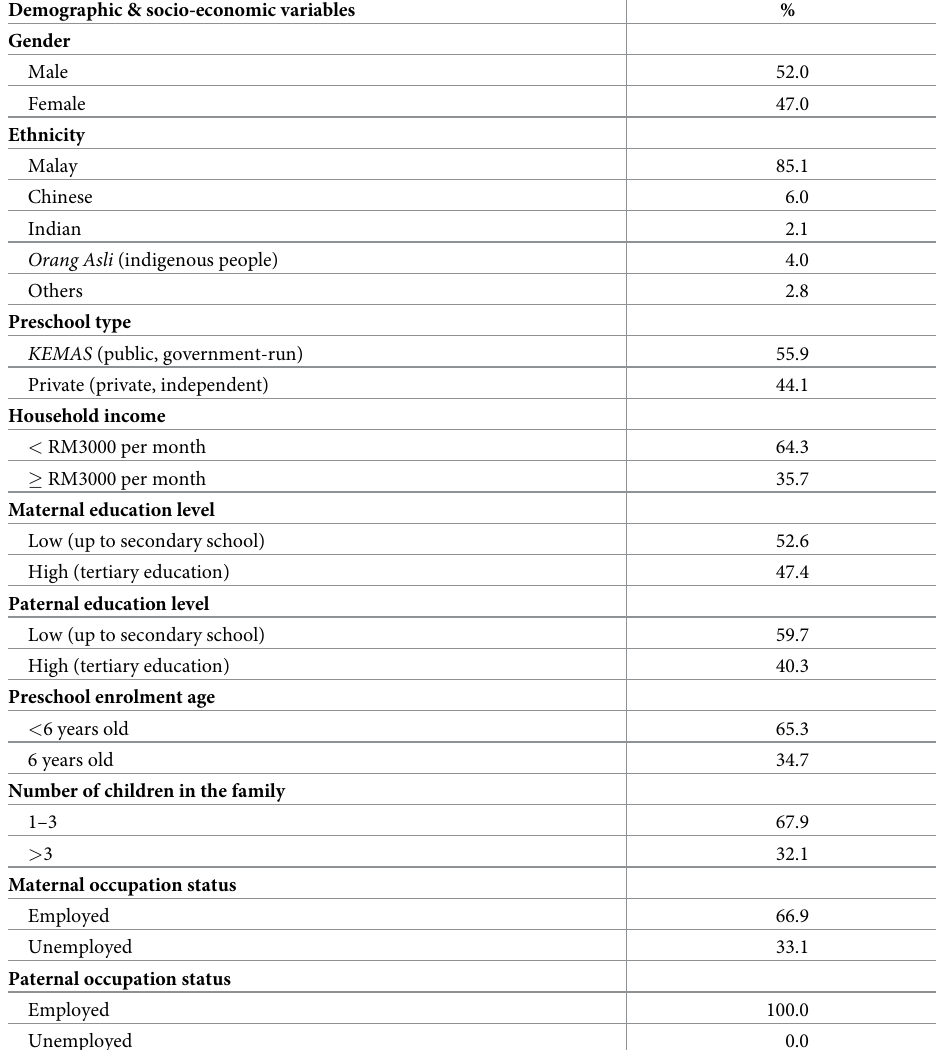
Table 1. Demographic and socioeconomic distributions of the study